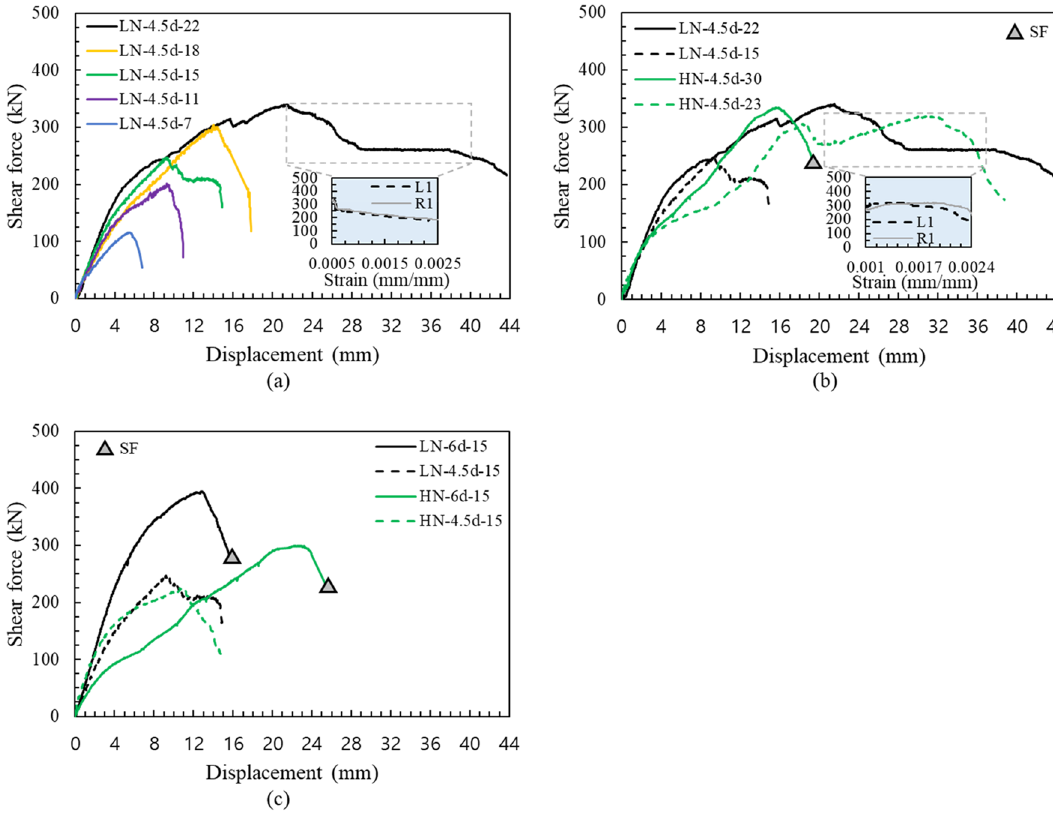
Figure 9. Load–displacement curve, embedment depth: ( a ) edge distance of 4.5d, ( b ) different embedment depth with two types of pedestal height, ( c ) same embedment depth with two types of pedestal